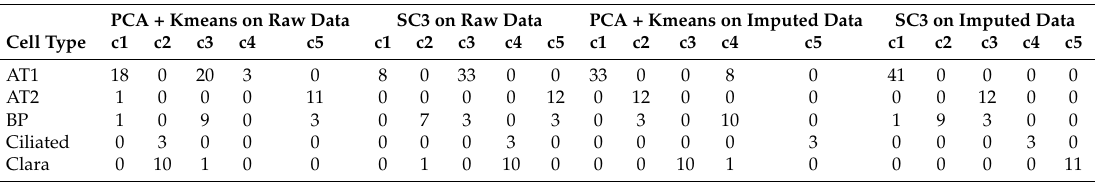
Figure 3. Clustering performance of data treated by netImpute compare to other existing methods. ( a ) Bar plot showing ARI obtained from applying PCA+kmeans on raw and imputed datasets ( b ) Bar plot showing ARI obtained from applying SC3 on raw and imputed datasets. Table 2. Treutlein confusion